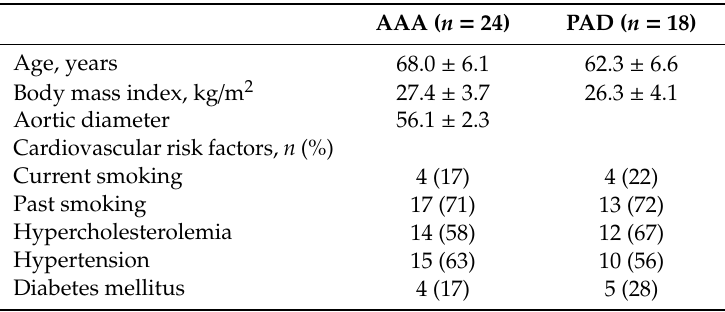
Table 1. Baseline characteristics of the study population.